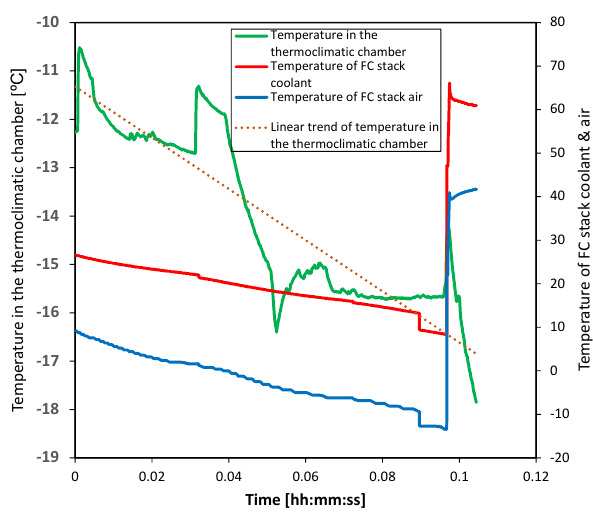
Fig. 15. Temperature of the cooling medium of fuel cells and air in the cell segments during vehicle tests in the thermoclimatic chamber [1,